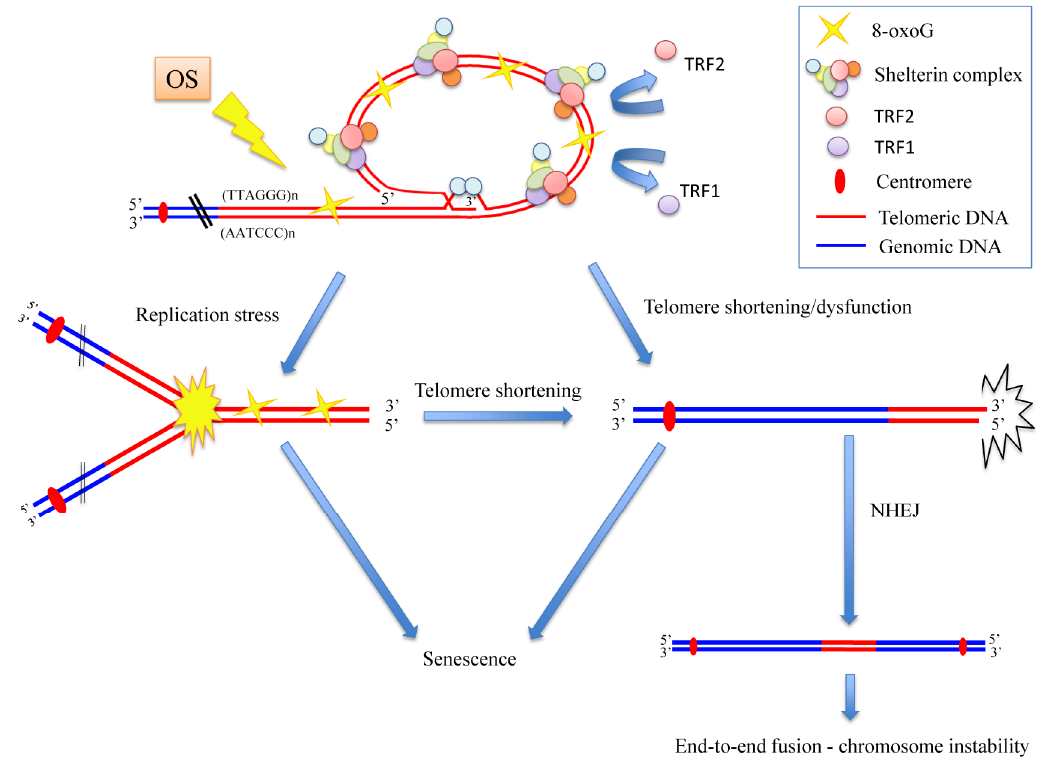
Figure 10. Model of how oxidative stress (OS) induces chromosome instability mainly by telomere damage. We suppose that 8-oxoG, induced by oxidative stress, is responsible of TRF1 and TRF2 reduction. The decreased binding of these telomeric proteins is responsible of replication fork arrest and telomere shortening/dysfunction that in turn cause senescence and chromosome instability, especially end-to-end fusions. NHEJ (non-homologous end joining).